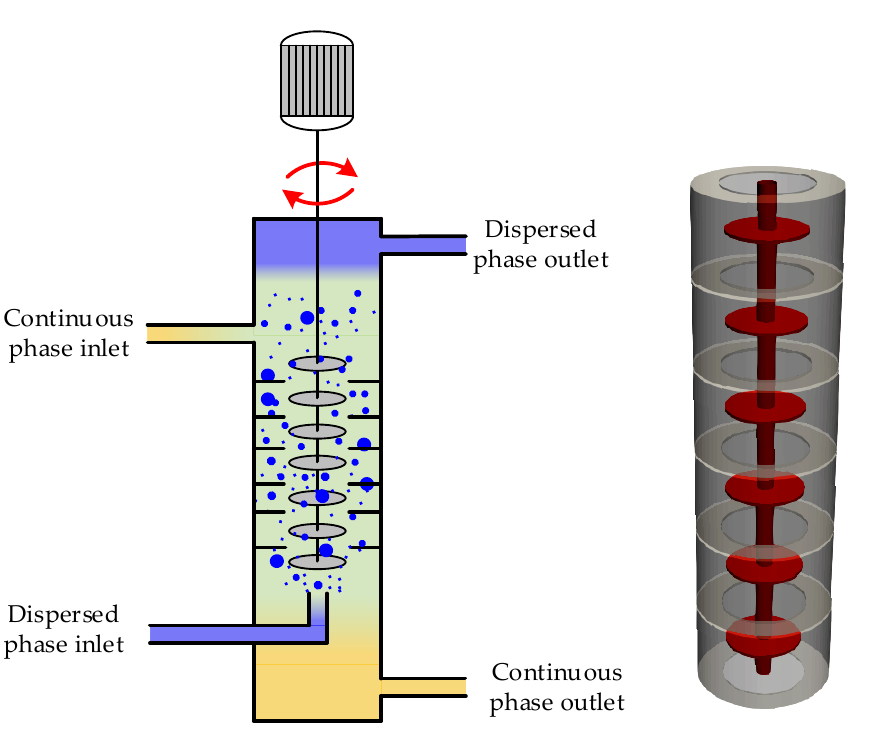
Figure 3. Schematic representation and a subsection of the axisymmetric computational domain used for the RDC simulation.